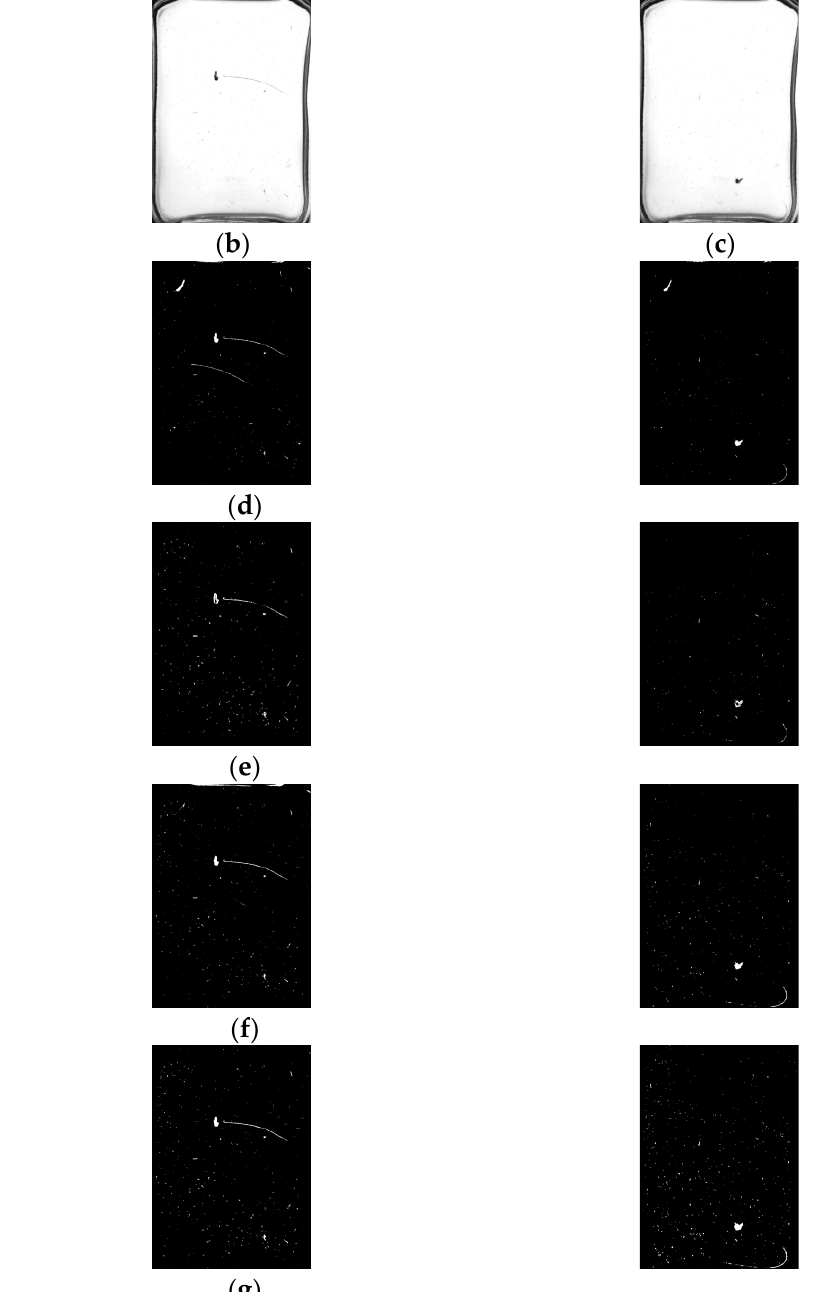
Figure 15. Examples of different algorithms for detecting impurities in bottled Baijiu. ( a ) Frame 34; ( b ) Frame 63; ( c ) Frame 212; ( d ) Result of the algorithm in the literature [36]; ( e ) Result of the frame difference method; ( f ) Result of traditional GMM background differential detection method; ( g ) Result of the algorithm in this paper.